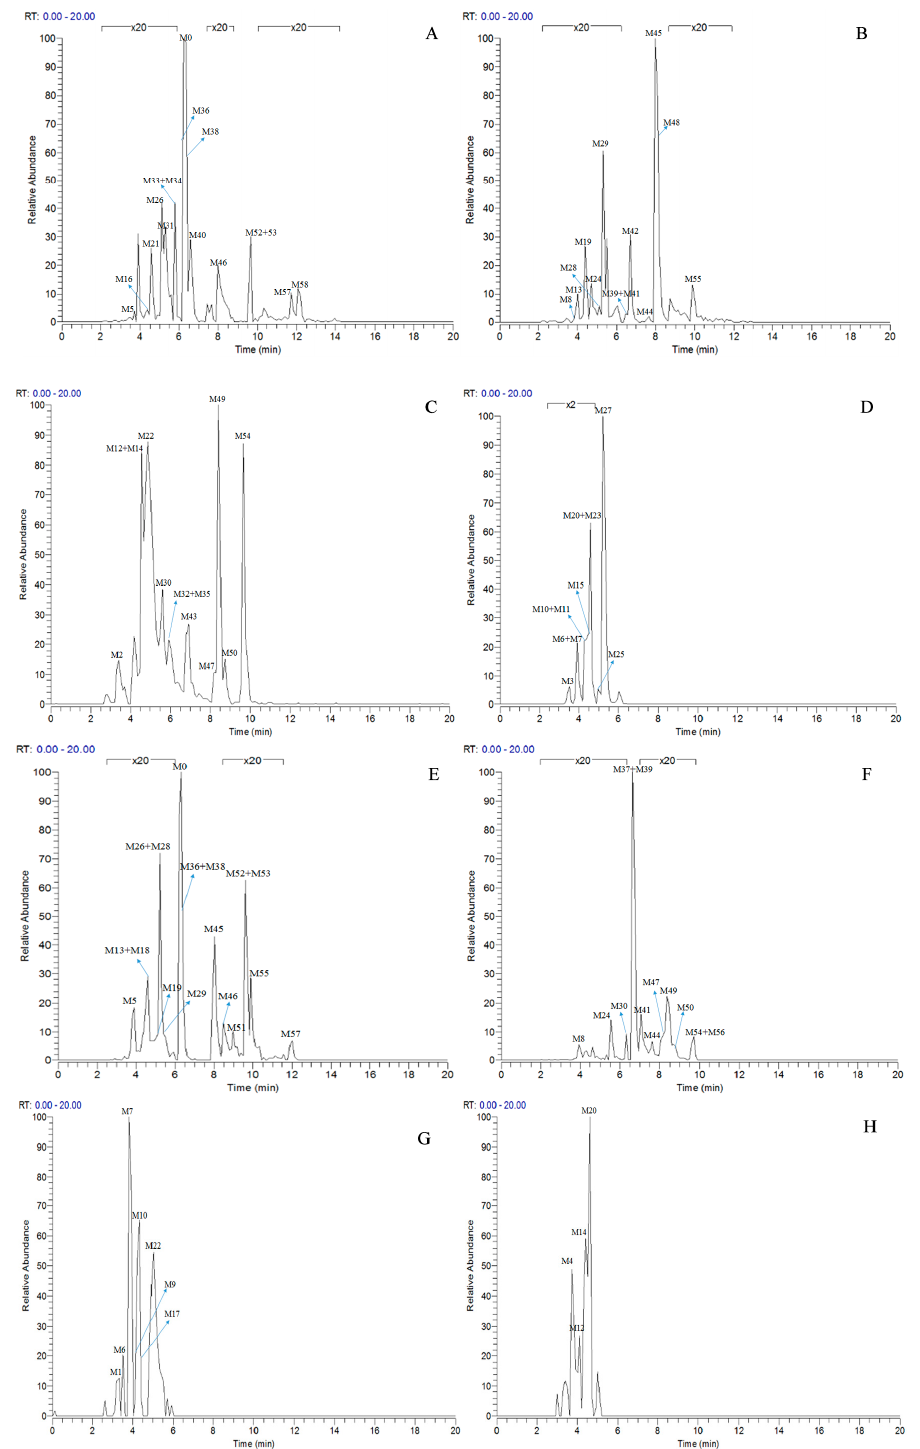
Figure 4. High resolution extracted ion chromatograms for the multiple daidzein metabolites in ±5 ppm error (( A – D ) for negative ion mode, ( E – H ) for positive ion mode): ( A ) m / z 225.0546, 239.0702, 241.0858, 253.0495, 255.0652, 257.0808; ( B ) m / z 267.0652, 269.0444, 271.0600, 283.0600, 285.0393, 285.0757; ( C ) m / z 287.0913, 299.0550, 333.0063, 335.0219, 337.0376, 593.1506, 595.1657; ( D ) m / z 415.1023,